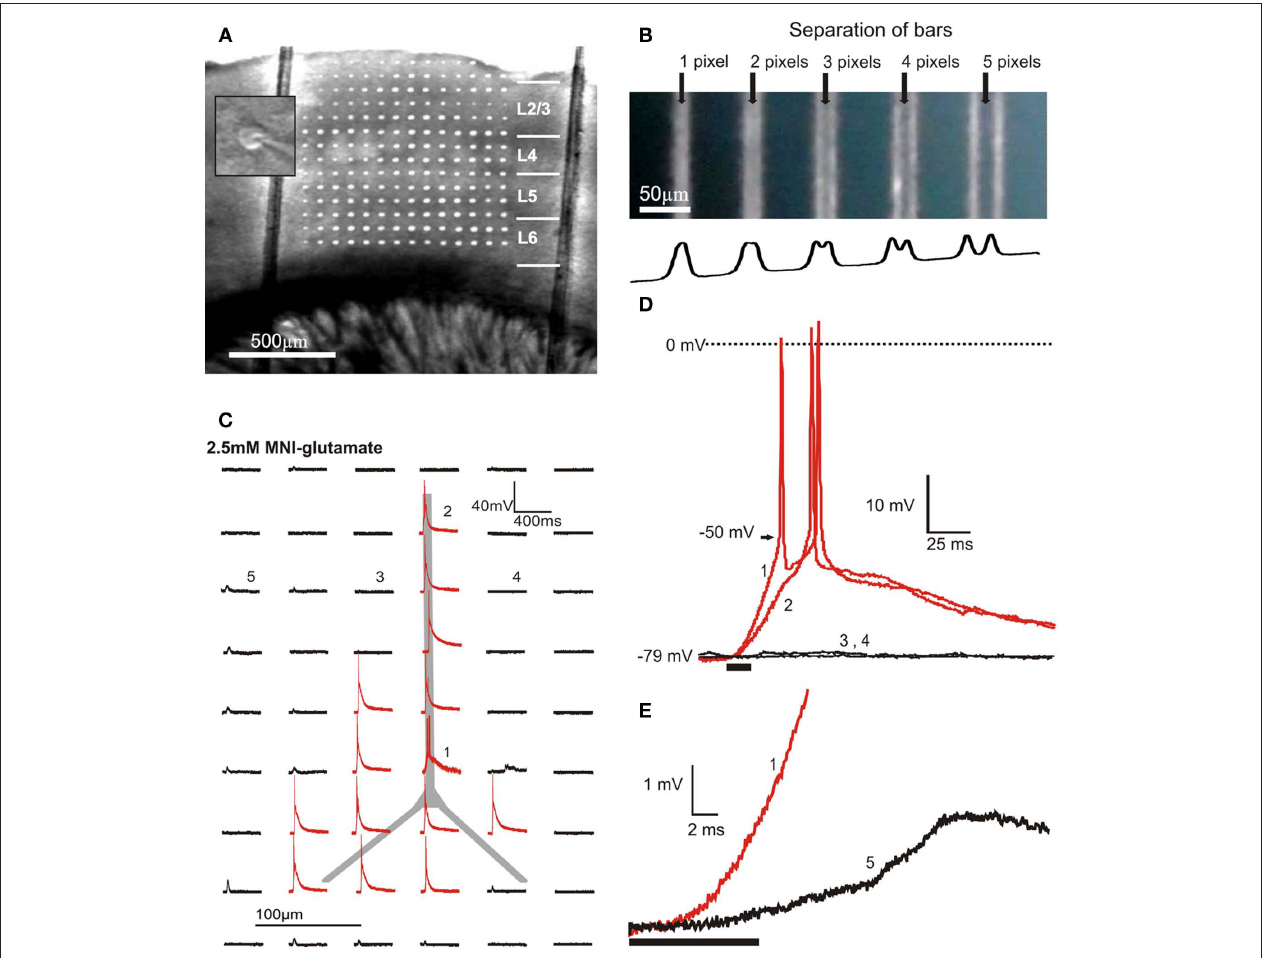
levels along the horizontal axis. (C) With 2.5 mM MNI-glu in the bath solution, photostimuli of 8 × 8 pixels (micromirrors) induce action potentials in a layer 2/3 pyramidal cell at sites aligned anatomically to the cell body or dendrites. The traces represent the membrane potential response elicited by photostimulation at each site. (D) Expanded views of the traces marked with numbers in (C) , showing action potentials elicited by photostimulation of the distal dendrite (2) and soma (1) of a layer 2/3 pyramidal cell as well as the absence of both subthreshold and suprathreshold responses to photostimulation of adjacent sites (3,4) on either side of the apical dendrite. The timing and duration of photostimulation (10 ms) is indicated with a black bar beneath the traces. (e) Synaptically induced responses (5) occur several milliseconds later than responses to direct